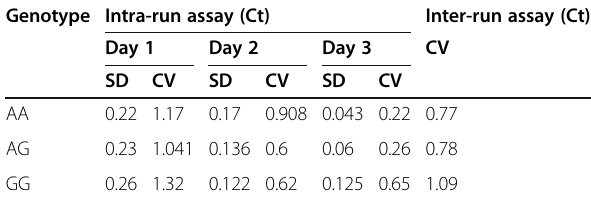
Table 1 Repeatability and reproducibility of HER-2 Ille655Val real-time